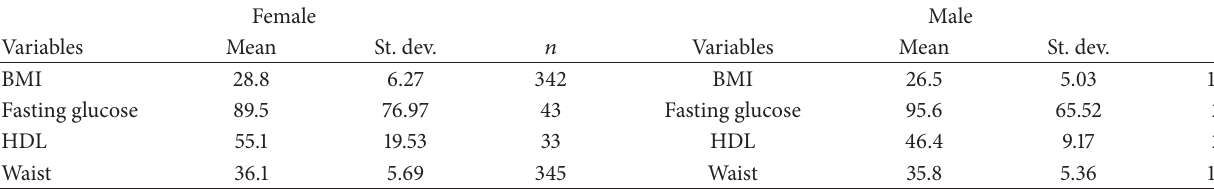
Table 2: Descriptive statistics for metabolic syndrome indicators.